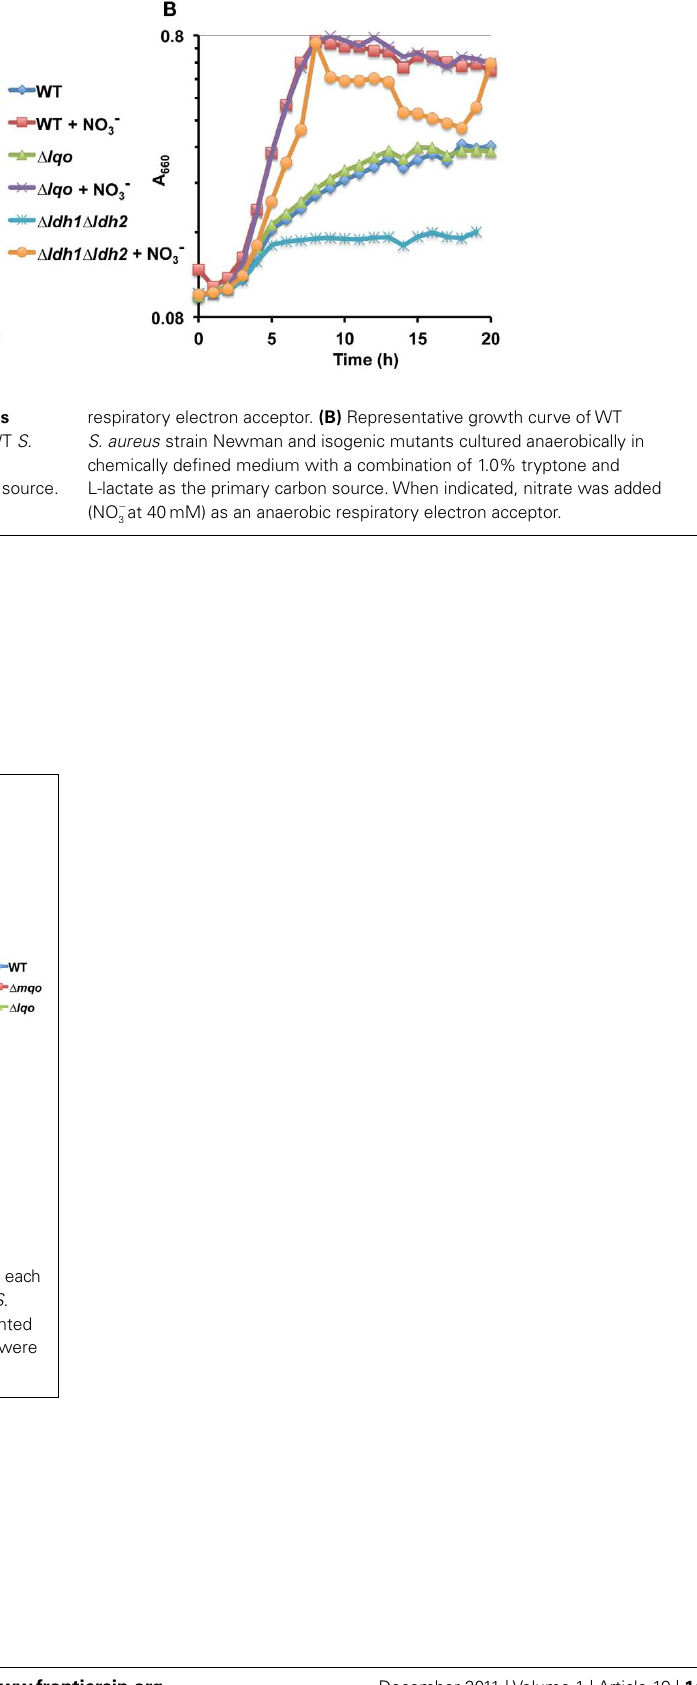
Frontiers in Cellular and Infection